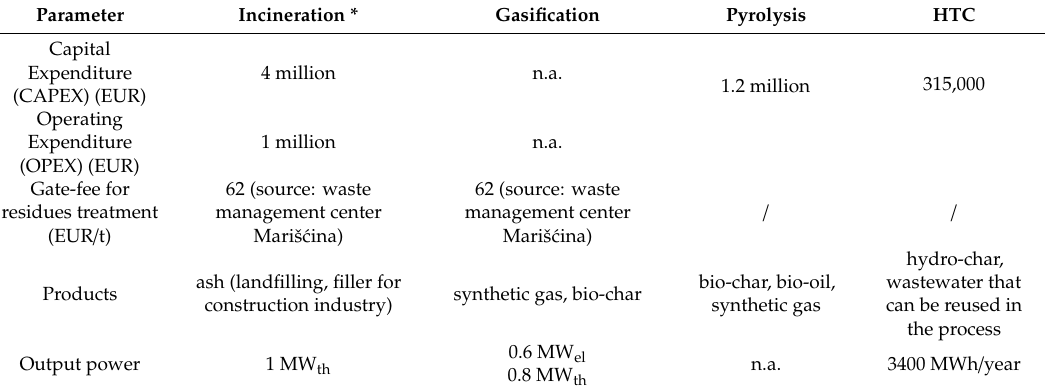
Table 5. Results of the literature overview for plants with similar sewage sludge / digestate capacity